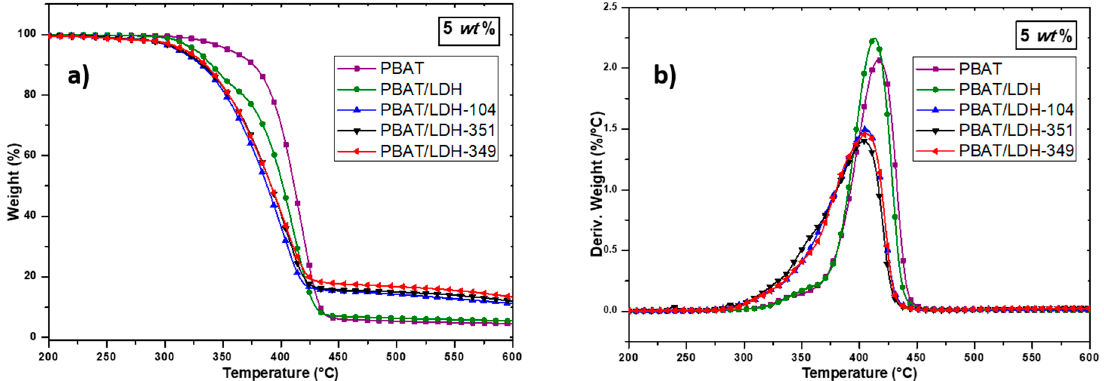
Figure 5. Evolution of weight loss obtained by TGA ( a ) and DTG ( b ) of the neat PBAT and PBAT-LDH (5 wt %) nanocomposites (heating rate 20 K·min − 1 under nitrogen flow).